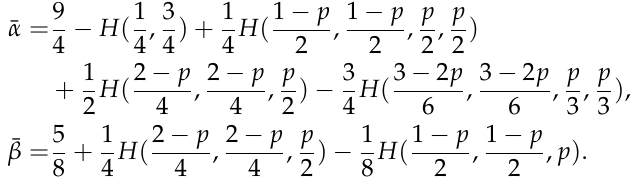
Table 1. Conditional distribution P X